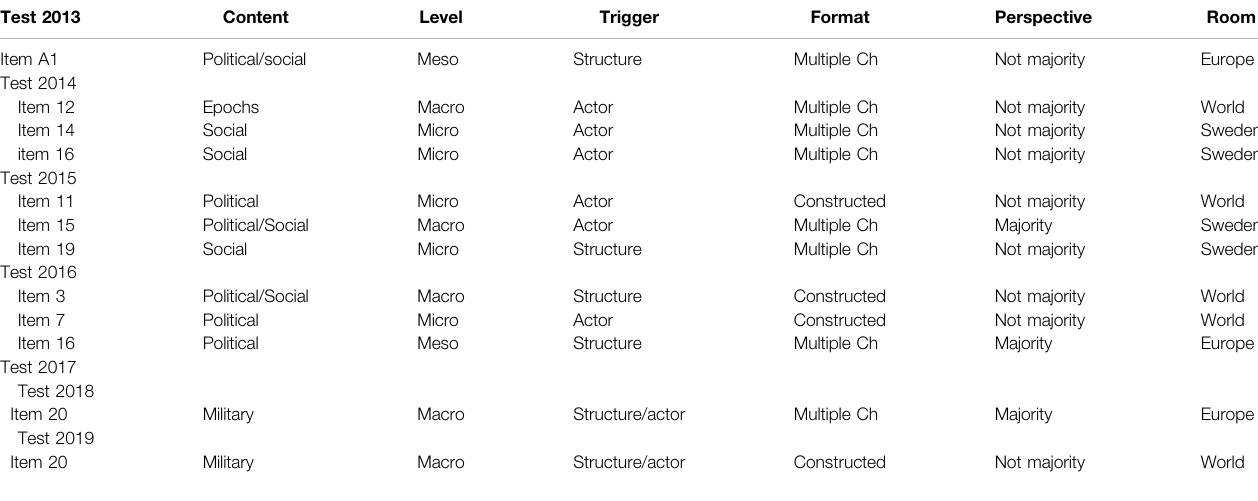
TABLE 3 | Tests and items with a DIF that favors the students taking the course Swedish as a second language,